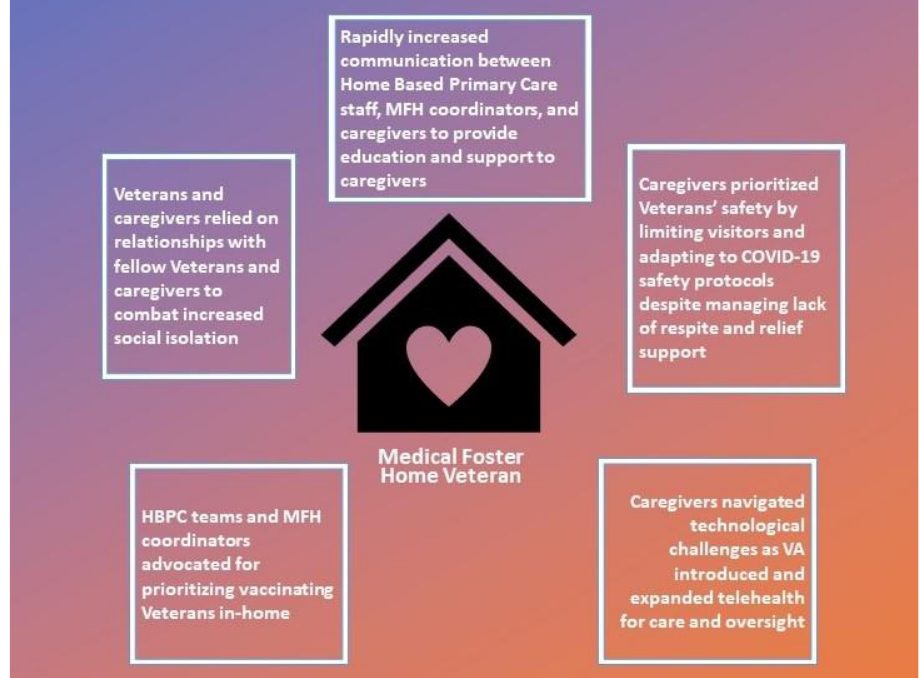
Figure 1. Themes identified that reflected adaptations to providing safe and high-quality care for rural MFH veterans during the COVID-19 pandemic . Table 2. Illustrative Quotations Reflective of Themes from the Study